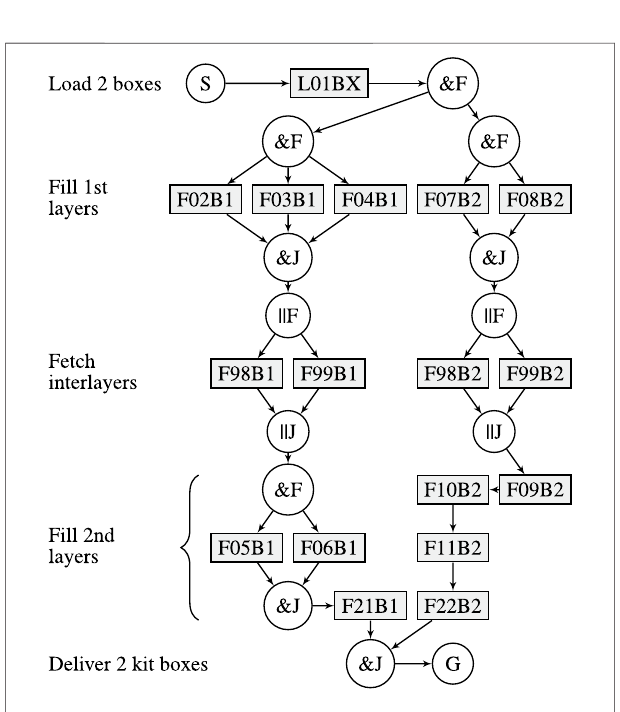
FIGURE 4 | RTSG representation of Scenario A.